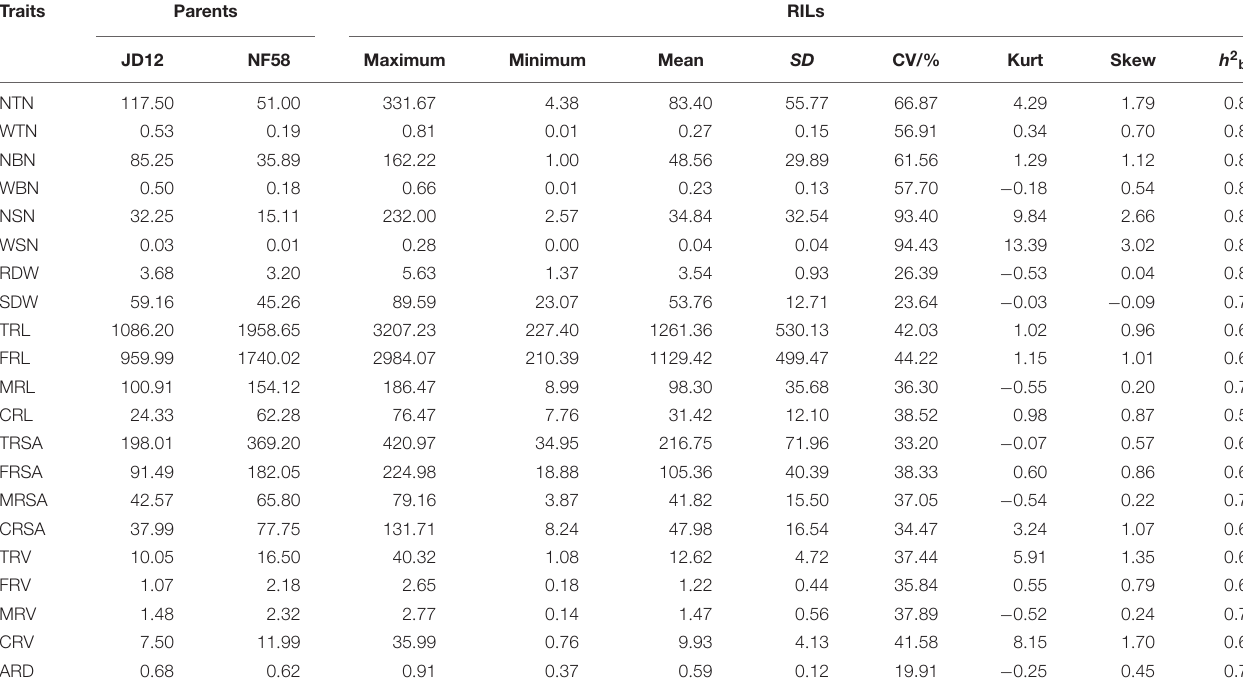
TABLE 1 | Phenotypic variation and genetic analysis of 21 traits using 175 F 9 : 11 soybean recombinant inbred lines (RILs) under natural conditions in the field.